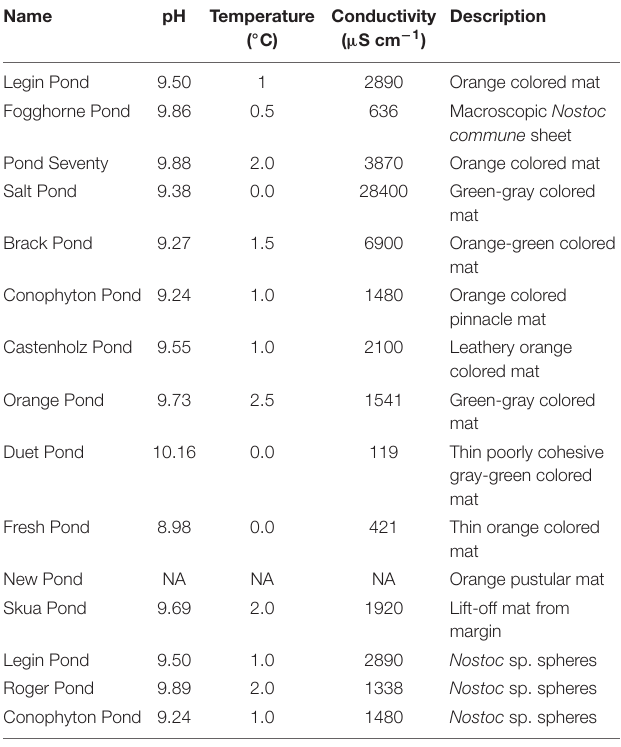
TABLE 1 | Investigated meltwater ponds, their physicochemical properties, and the description of the microbial mats in the ponds.